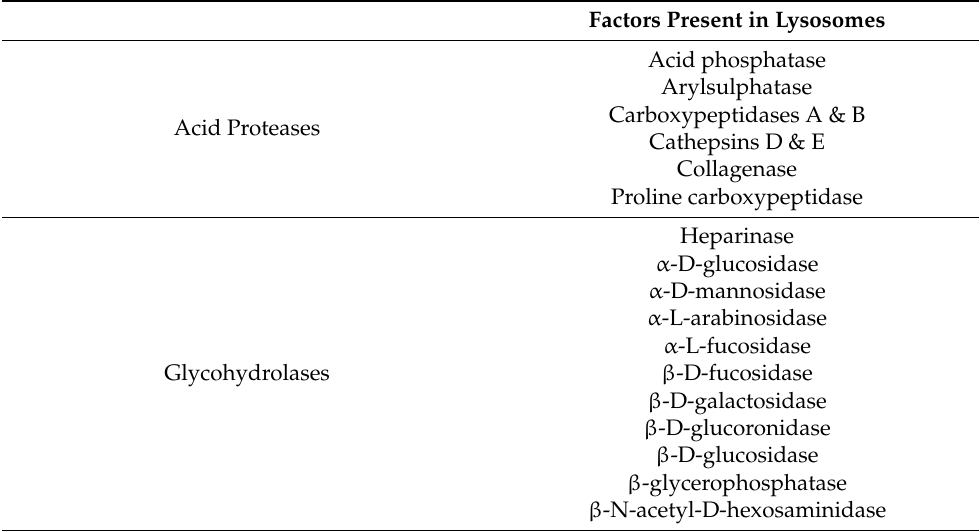
Table 3. Overview of factors present in lysosomes [15–20]. Lysosomes are known to also degranulate upon platelet activation and contain various digestive enzymes that are activated under acidic conditions.